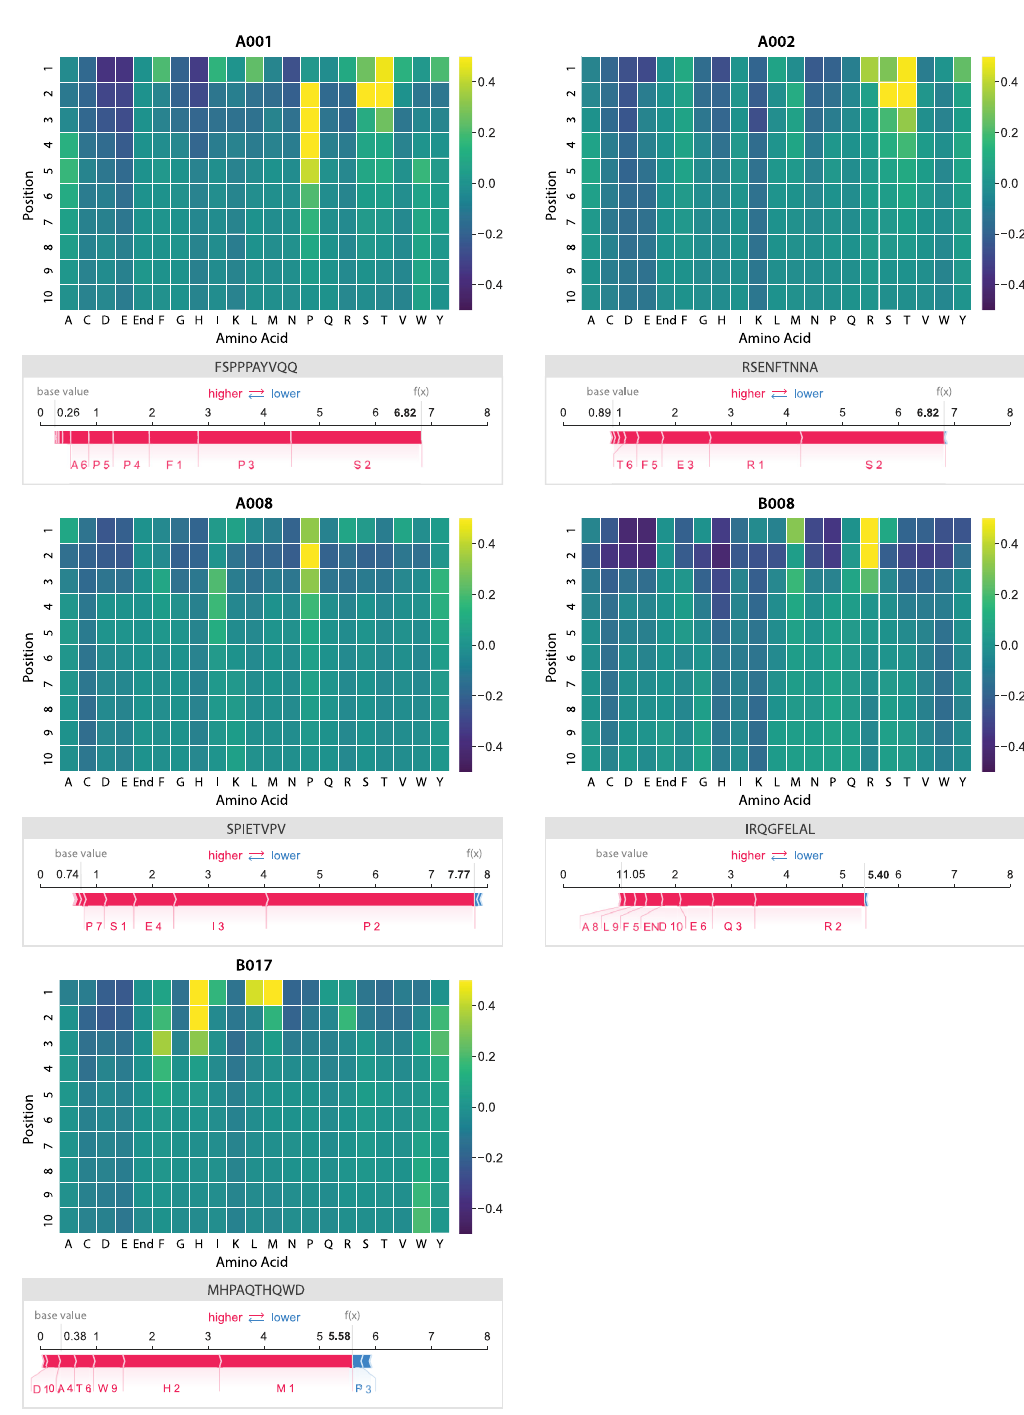
Fig 3. Heatmaps showing PoSHAP analysis to determine amino acid binding motifs from deep learning models. The mean SHAP values for each amino acid at each position across all peptides in the test set were arranged into a heatmap. The position in each peptide is along the y-axis and the amino acid is given along the x-axis. “End” is used in positions 9 and 10 to enable inputs of peptides with length 8, 9, or 10. For comparison, the SHAP force plot for the peptide with the highest binding prediction is shown below each